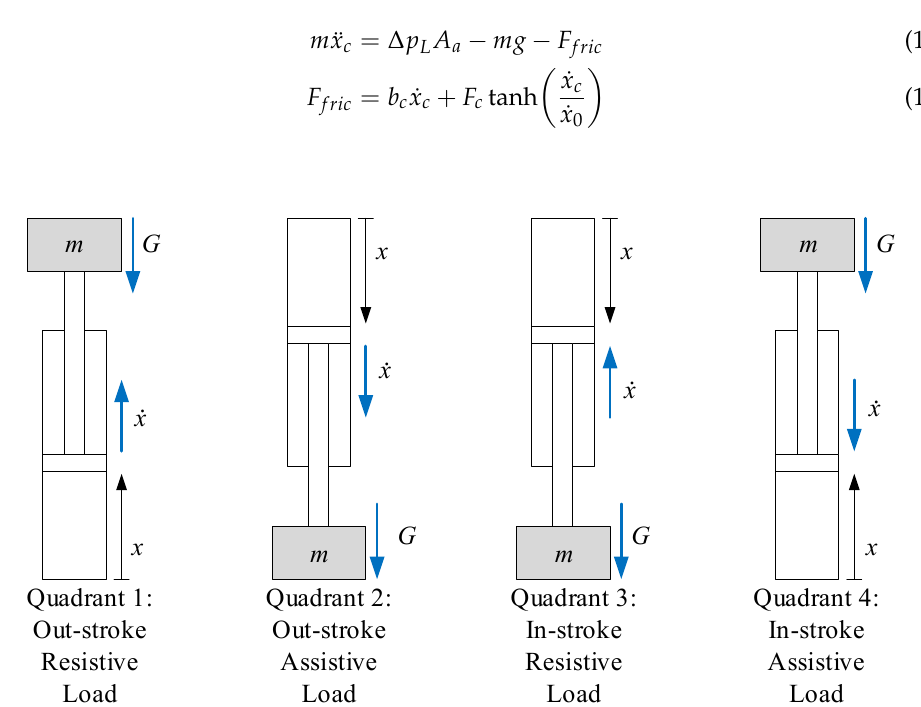
Figure 11. Illustration of four quadrant cylinder velocity and load mass with vertical